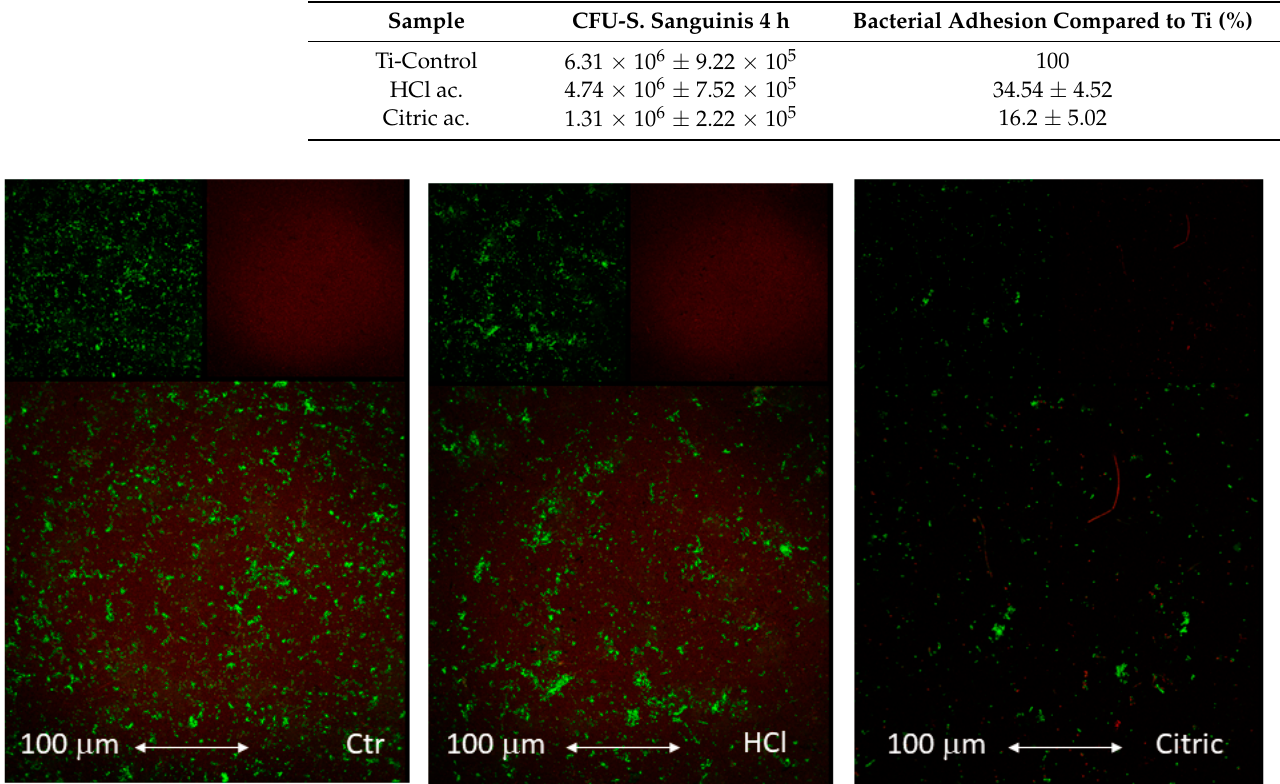
Table 4. Number of S. sanguinis bacteria after 4 h and the ratio of S. sanguinis adhered compared to unpassivated samples.